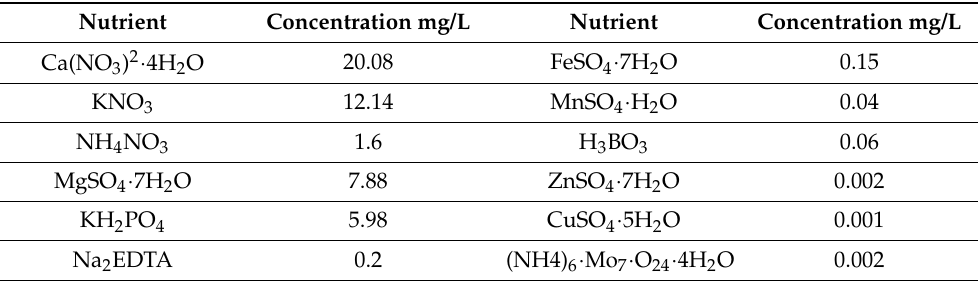
Table 1. Composition of Hoagland solution